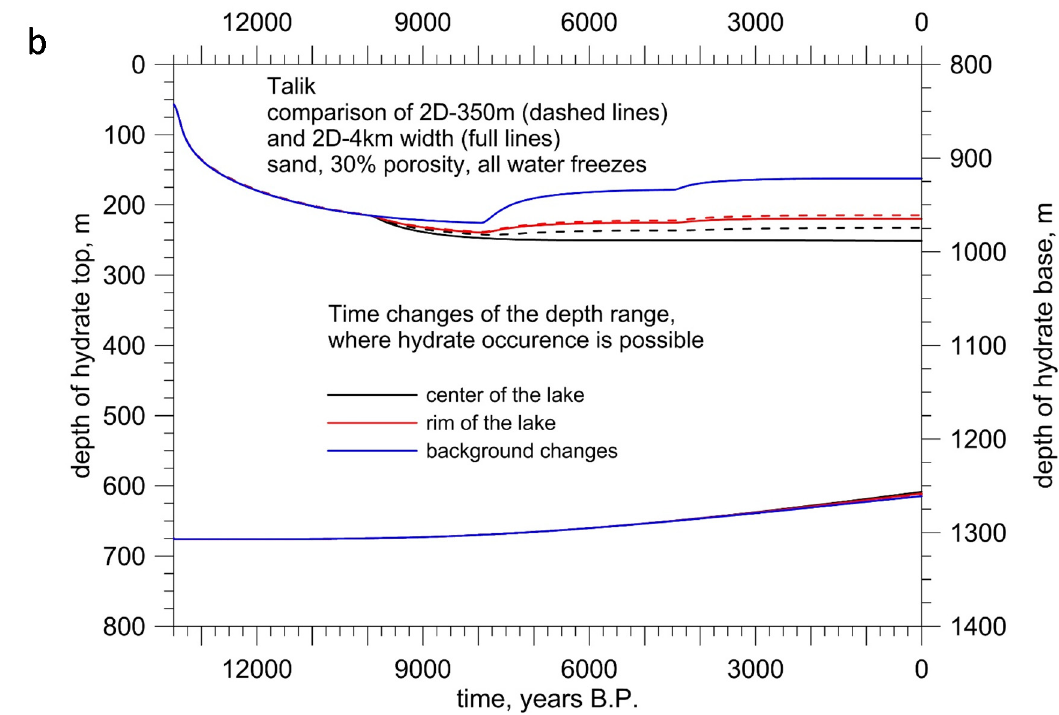
Figure A2. Temporal changes of the upper and lower boundaries of the permafrost ( a ) and methane GH layers ( b ) at: The lake’s centre, rim and beyond both a small 350 m (dashed lines) and a large 4 km (solid lines) lake width.